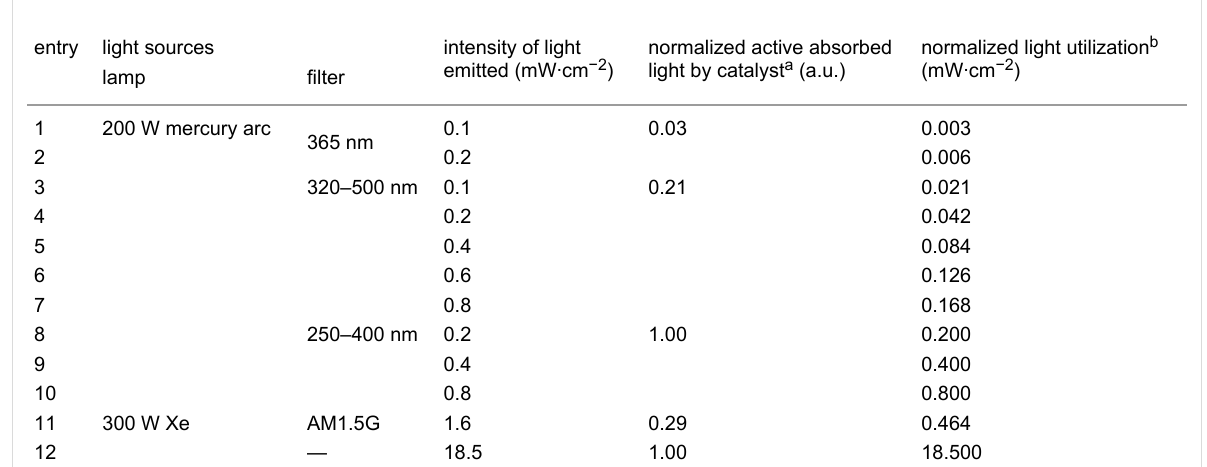
entry light sources